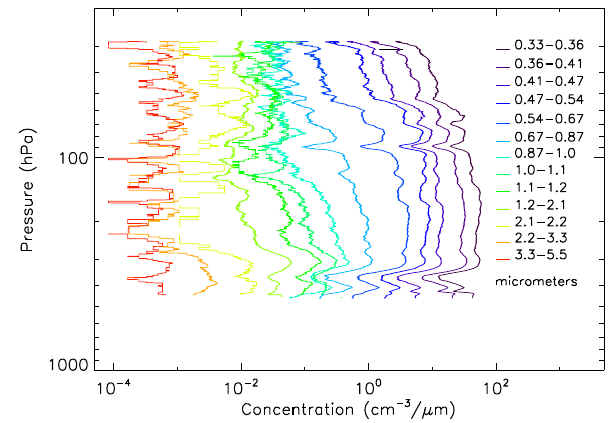
Fig. 1. Vertical profiles of the charged and uncharged aerosol con- centration, on 12 March 2011 from Kiruna (northern Sweden) dur- ing the balloon